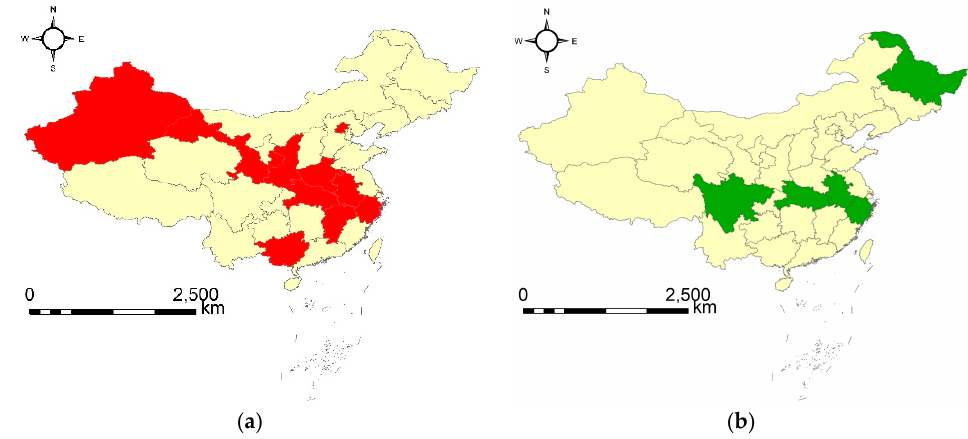
Figure 6. The discovered geographical flock patterns: ( a ) {1, 4, 11, 12, 14, 16, 17, 20, 27, 30}|[1998, 2000] (type II), and ( b ) {8, 11, 12, 17, 23}|[2014, 2017] (type III). Table 4. The discovered geographical flock patterns based on the criterion of the extreme number- duration values on the province level.